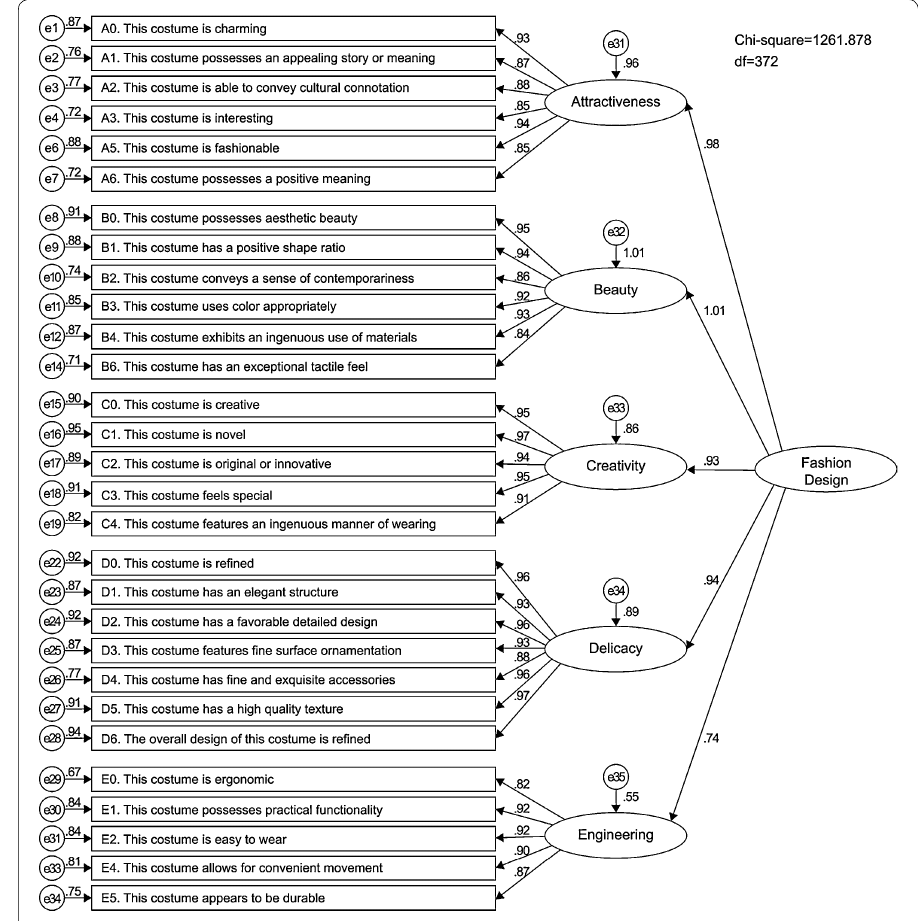
Fig. 1 The model of cultural elements into fashion